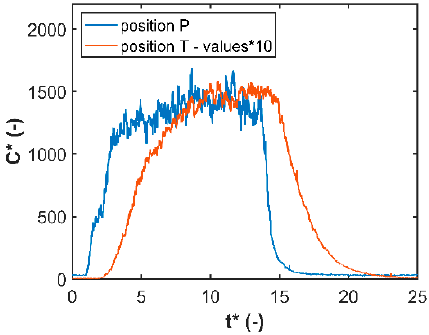
Figure 9. Mean concentration time series for the clouds with the release duration 12 for both explored positions (note: the statement values*10 means that the values were multiplied by 10 to be able to show the results of both positions in one figure).